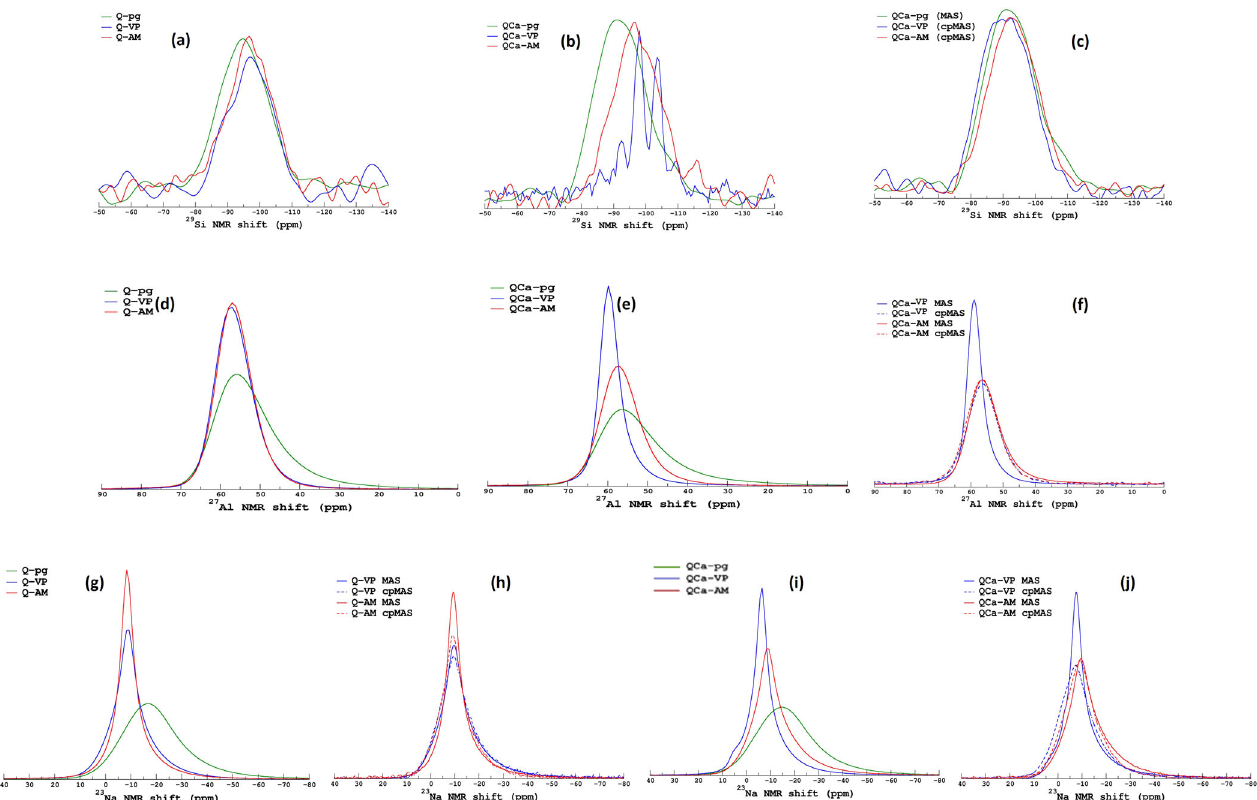
Fig. 6 29 Si, 27 Al and 23 Na MAS and CPMAS NMR spectra. a , b 29 Si MAS NMR spectra of the unaltered (pristine) glass of natural isotopic abundance (pg), glass altered in vapor phase (VP) and aqueous medium (AM) for the Q and QCa glass respectively; c 29 Si CPMAS spectra for QCa glass altered in vapor phase (VP) and aqueous medium (AM) and 29 Si MAS NMR spectra of the unaltered pg sample; d , e 27 Al MAS NMR spectra of pg, VP and AM samples of Q and QCa glasses respectively; f 27 Al MAS and CPMAS NMR spectra for AM and VP samples of QCa glass; g 23 Na MAS NMR spectra of pg, VP and AM samples of the Q glass; h 23 Na MAS and CPMAS NMR spectra for AM and VP samples of the Q glass; i 23 Na MAS NMR spectra of pg, VP and AM samples of the QCa glass; j 23 Na MAS and CPMAS NMR spectra for AM and VP samples of the QCa